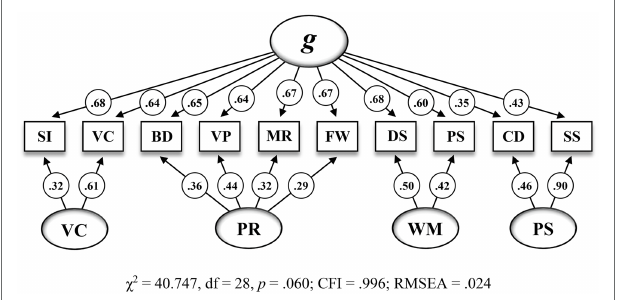
FIGURE 1 | Second-order five-factor model including standardized estimations for the CFA sample (n = 823) on the 10 WISC-V primary subtests (M 6 in Table 6). SI = Similarities, VC = Vocabulary, BD = Block Design, VP = Visual Puzzles, MR = Matrix Reasoning, FW = Figure Weights, DS = Digit Span, PS = Picture Span, CD = Coding, SS = Symbol Search. g , = General Intelligence, VC = Verbal Comprehension, VS = Visual Spatial, FR = Fluid Reasoning, WM = Working Memory, PS = Processing Speed. All standardized parameter estimates are significant at p < 0.001.